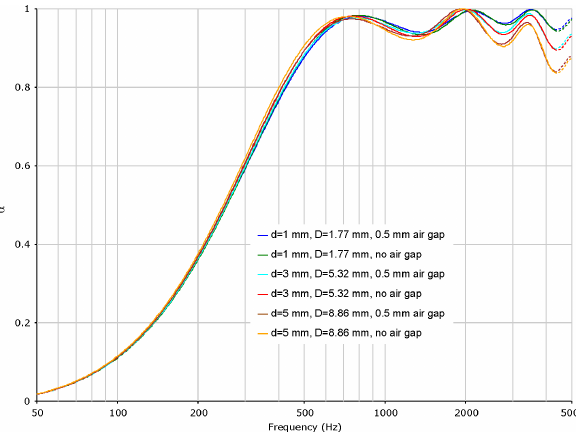
Figure 18: Influence of the hole diameter ( σ = 25 %, t = 1